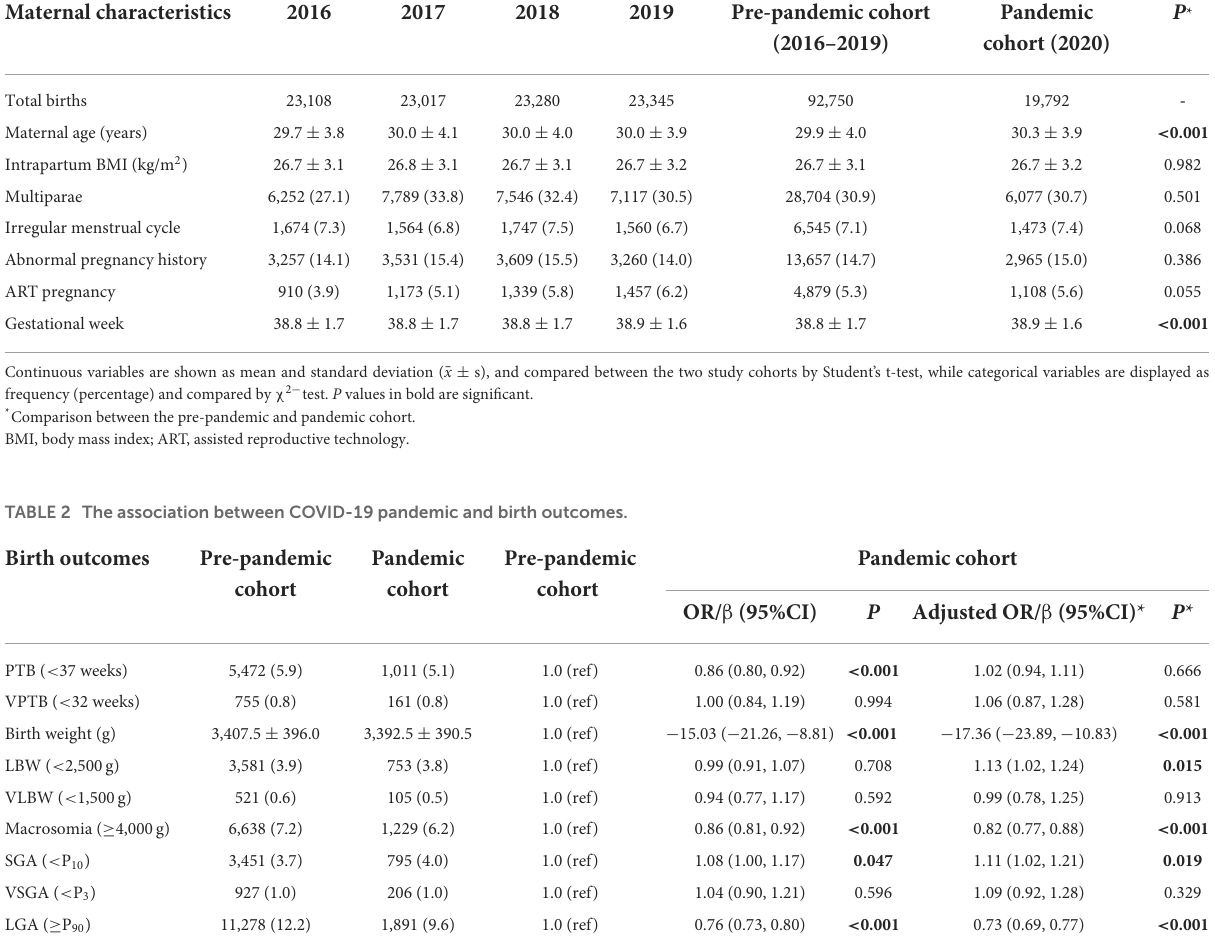
TABLE 1 Maternal characteristics between the pre-pandemic and pandemic cohort. Maternal characteristics